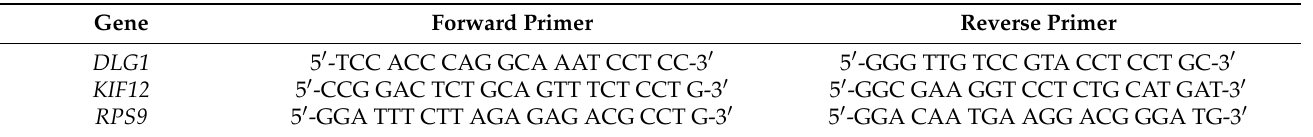
Table 2. Primers used in